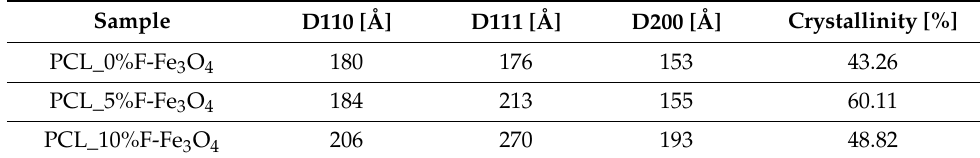
Figure 3. XRD spectra of: ( a ) PCL_0%F-Fe 3 O 4 ; ( b ). PCL_5%F-Fe 3 O 4 ; ( c ) PCL_10%F-Fe 3 O 4 ;. Table 3. Crystallite coherence lengths perpendicular to reflection planes 110 (D110), 200 (D200), and 111 (D111) and crystallinity values of the unloaded PCL membrane and membranes loaded with 5% and 10% F-Fe 3 O 4 nanoparticles.